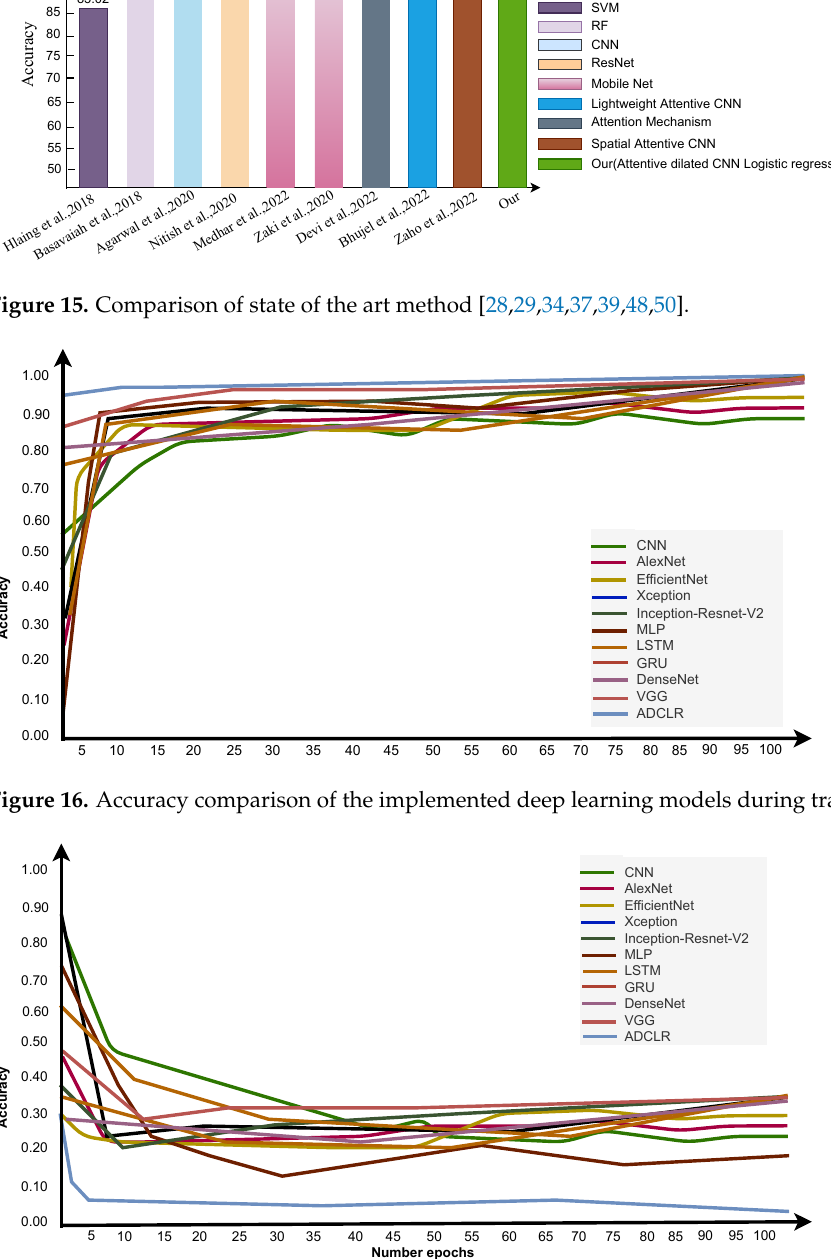
Figure 17. Loss comparison of the implemented deep learning models during